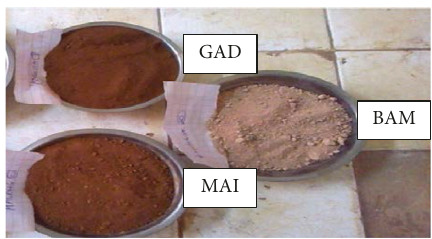
Figure 1: Soilsamples collected MAY, GAD, and